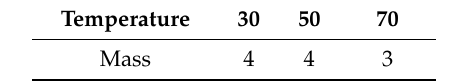
Table 3. The mass of the deposit (in mg) produced at the three tested temperatures (in °C). Temperature